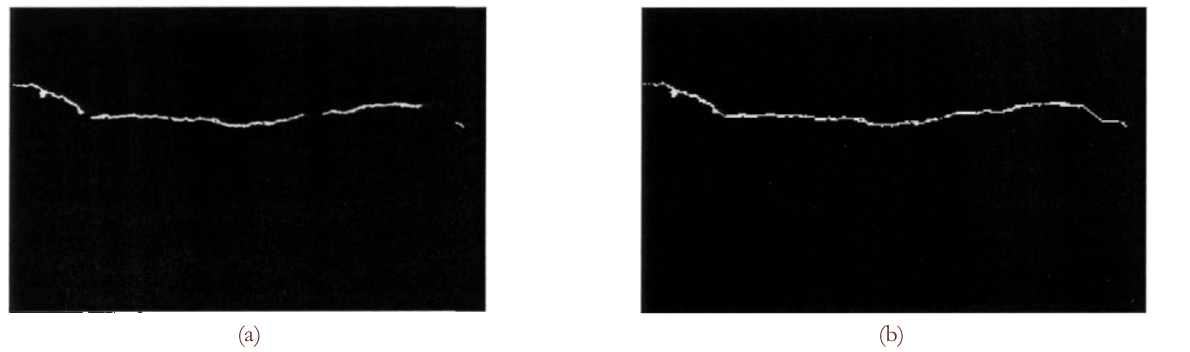
Figure 6: (a) Crack fragment image; (b) Crack fragment after